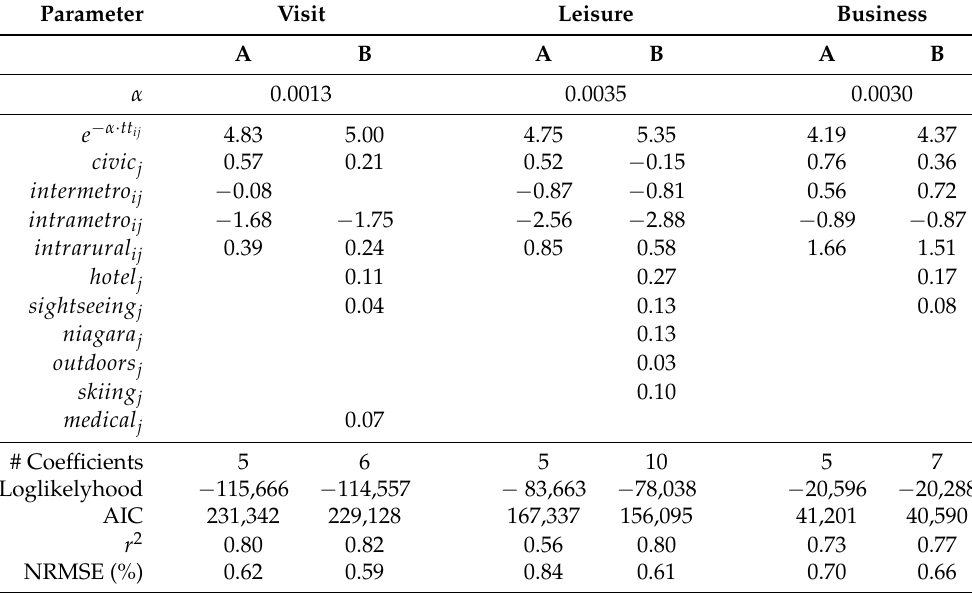
Table 4. Model estimation results (for all coefficients, Pr ( > | t | ) <